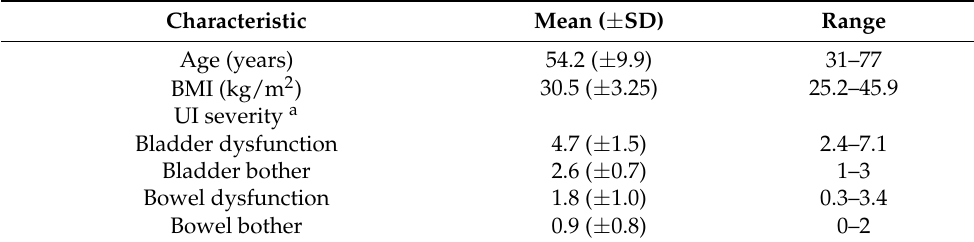
Table 1. Participant characteristics.